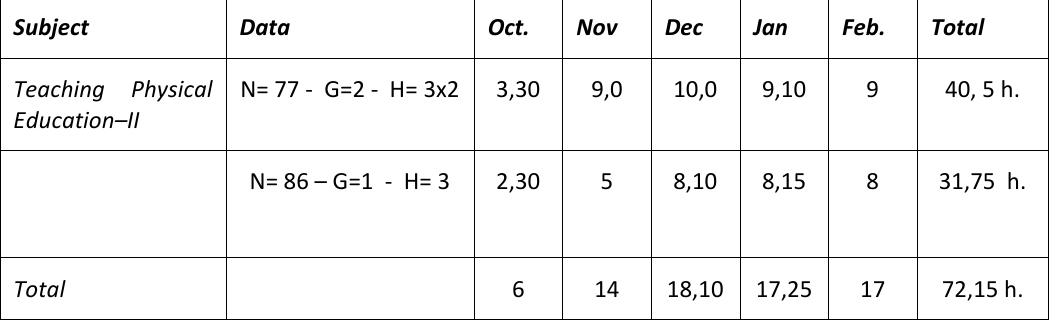
Table 10 .Professor workload by subject and